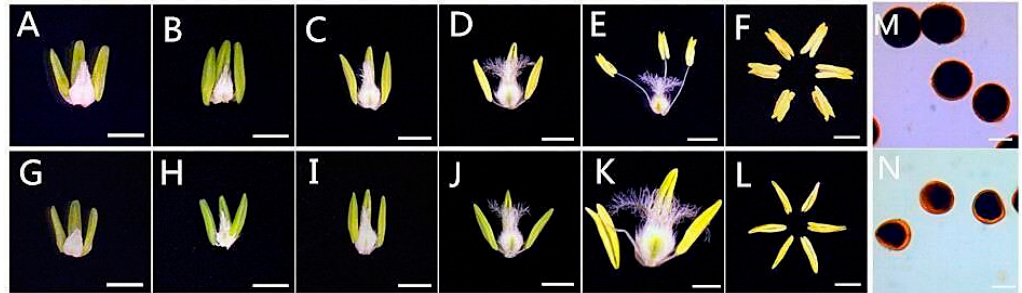
Figure 1. Comparison of plant anthers and I 2 –KI staining in sterile/fertile conditions (AF: ( A – F , M ); AS: ( G – L , N )). ( A , G ) Tetrad stage; ( B , H ) early uninucleate stage; ( C , I ) later uninucleate stage; ( D , J ) binucleate stage; and ( E , F , K , L ) trinucleate stage. Scale bars are 500 μ m in ( A – F ) and ( G – L ); 50 μ m in ( M , N ).